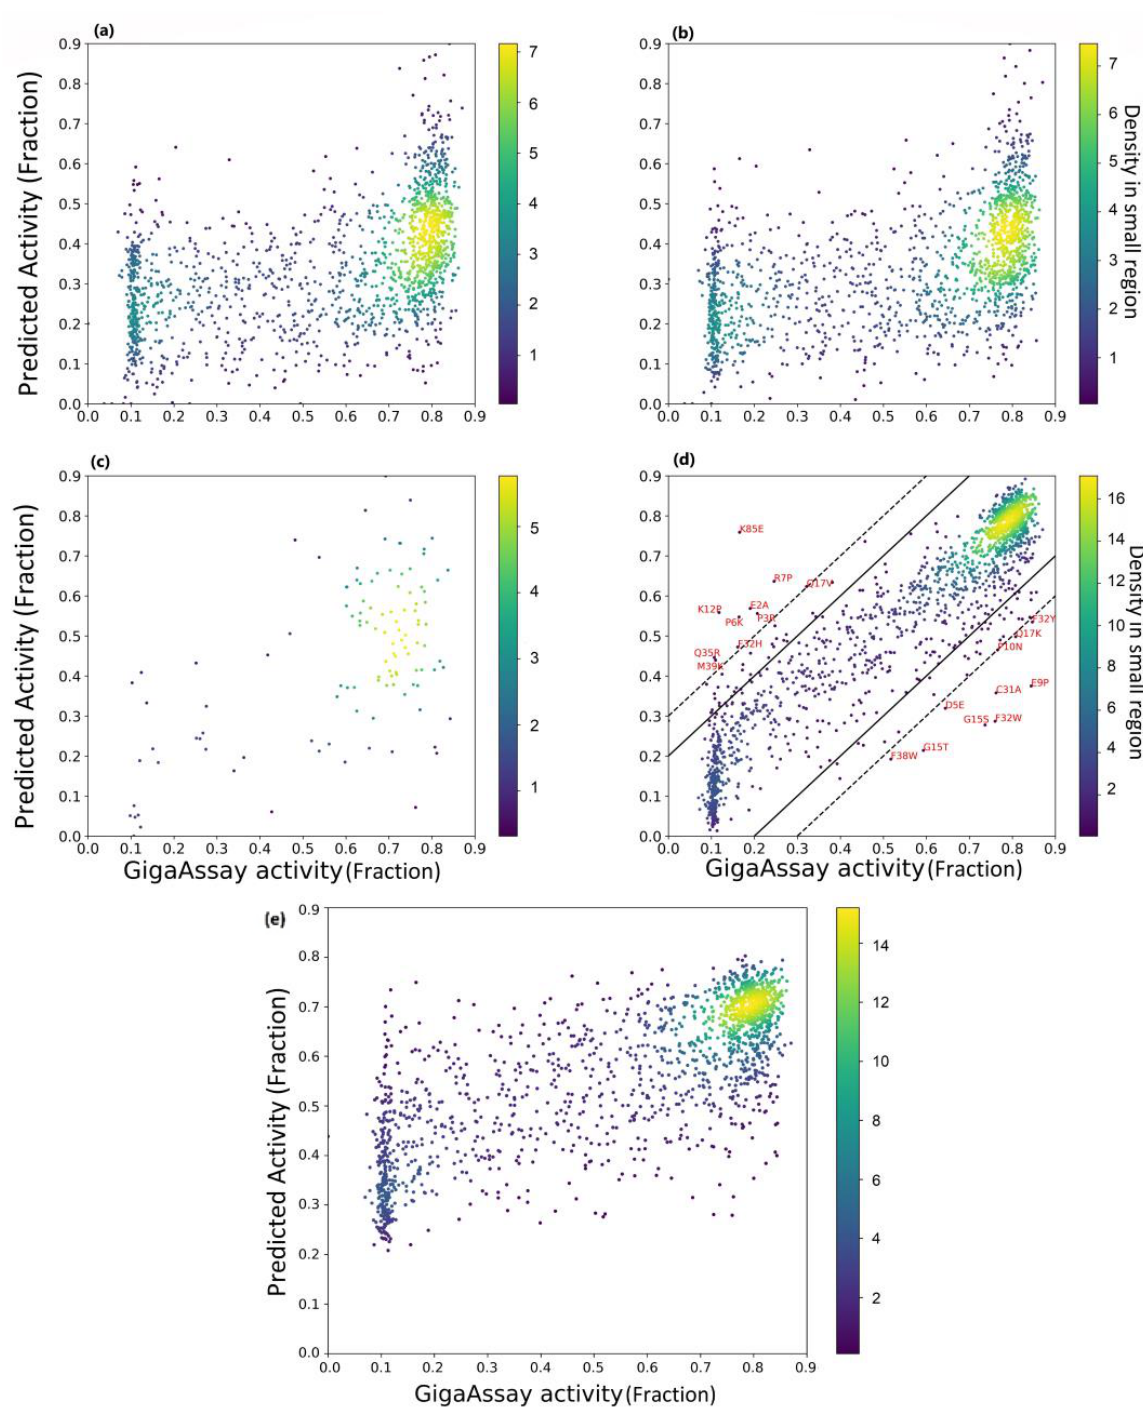
Figure 2. Comparison of activity estimation by Rep2Mut with two state-of-the-art methods. ( a ) ESM_pred: the best performance among the 5 ESM_pred estimation. ( b ) ESM_pred _avg: the performance of averaging the five ESM_pred estimation of variants. ( c ) DeepSequence. ( d ) Rep2Mut. The solid line: the error margins of 0.2, and the dashed line: an error margin of 0.3. Amino acid mutation outliers are labeled in red font. ( e ) A baseline method. Color legend at the right: the density of the dots in graph.